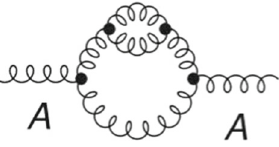
Fig. 1 Two-loop diagram which contains a gluon loop as